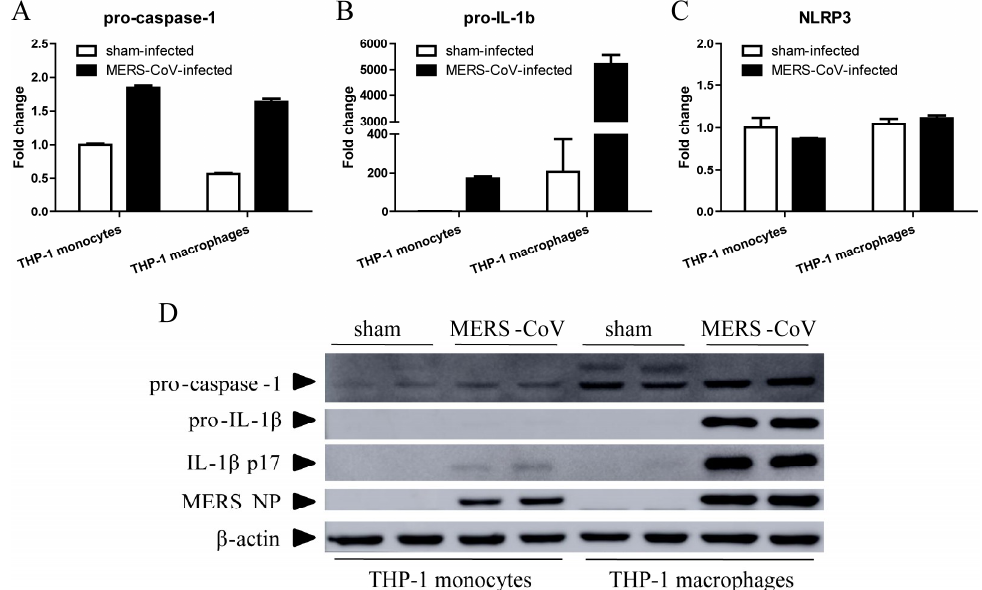
Figure 1. MERS-CoV infection induces pyroptosis in THP-1 macrophages. THP-1 monocytes and macrophages were infected with MERS-CoV for 24 h. Total RNA and protein was then extracted from the cells using TRIzol Reagent. ( A – C ) Total RNA was used for RT-qPCR to detect transcription of pro-caspase-1, pro-IL-1β, and NLRP3. Data are expressed as means ± SEM ( n = 2 per group). ( D ) Samples of total protein were subjected to Western blotting to detect pro-caspase-1, pro-IL-1β, activated IL-1β, and MERS NP.